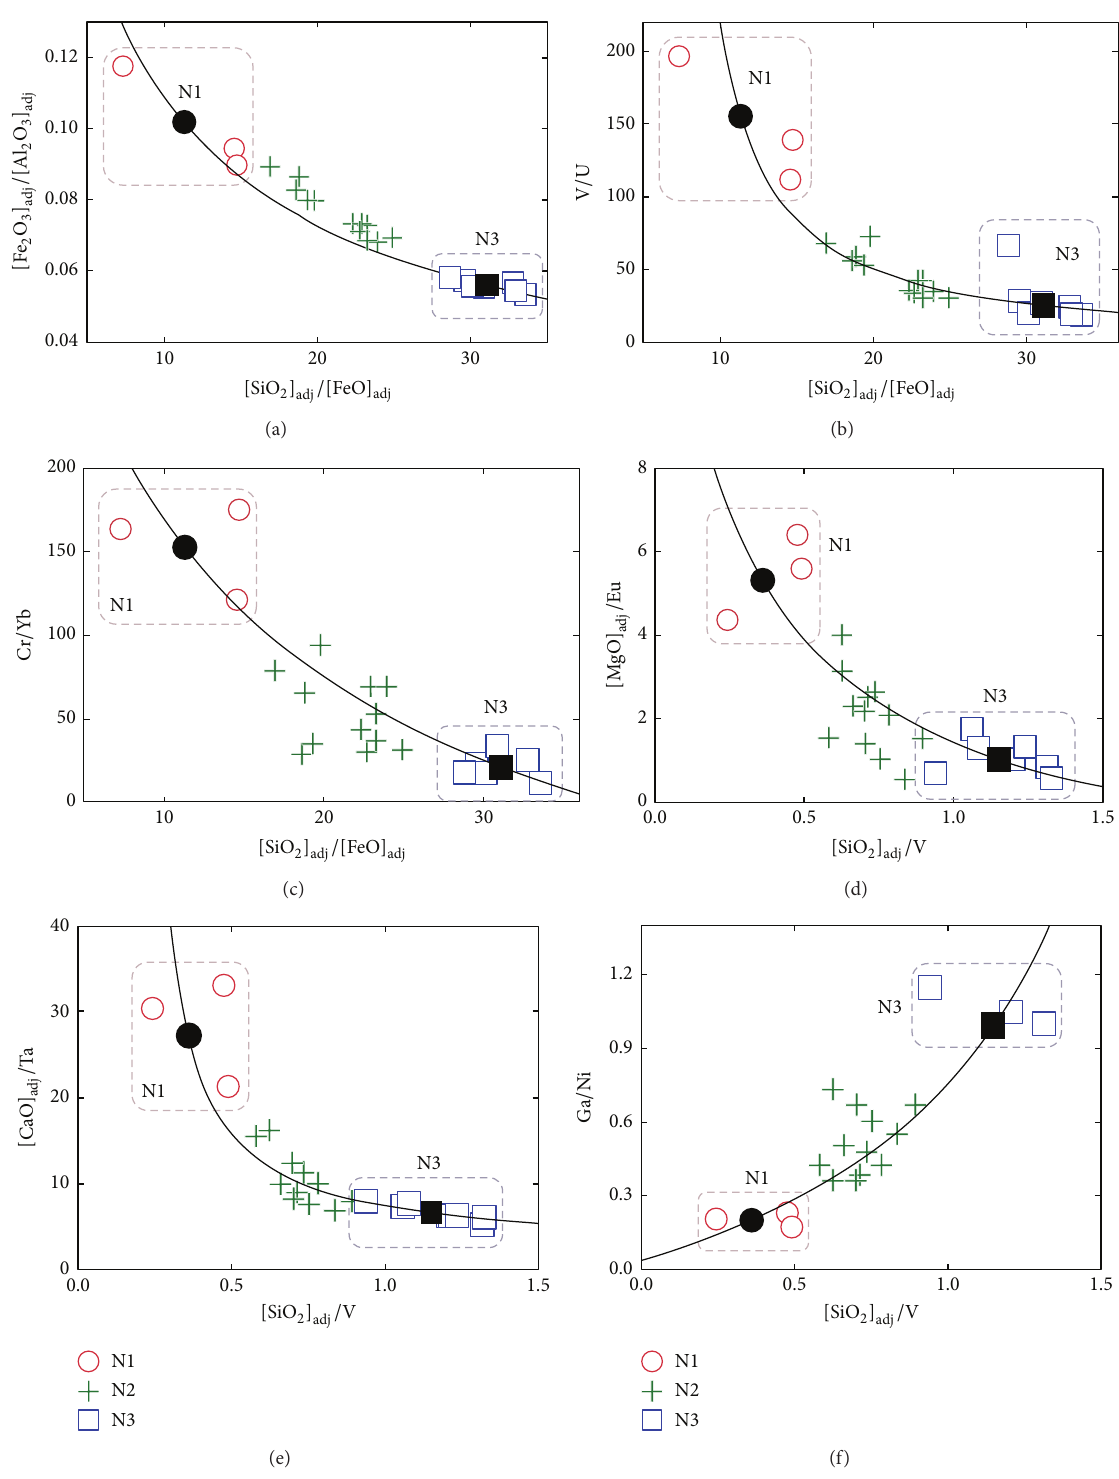
Figure 16: Geochemical ratio-ratio diagrams of the Sierra de las Cruces northern sector that include hyperbolic mixing models (black solid line) between average intermediate N1 lavas (black filled circle, 𝐼 ] /[ Al ] − [ SiO ] /[ FeO ] [ Fe ; (b) V/U −[ SiO 2 ] 2 O 3 2 O 3 2 adj adj adj adj [ CaO ] /Ta −[ SiO 2 ] /V; (f) Ga/Ni −[ SiO 2 ] /V. Hyperbolic mixing equations, generated following the mass-balance approach by Zou [33], adj adj adj are reported in Table